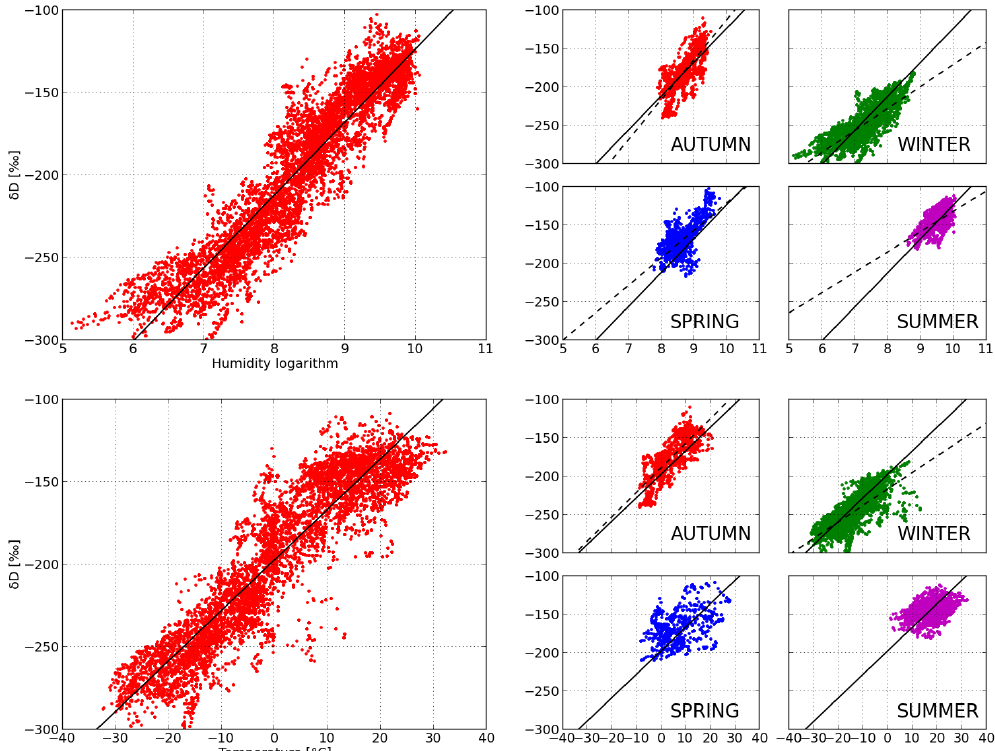
Figure 8. δ D vs. logarithm of humidity (top) and δ D vs. temperature (bottom). Left panels: all measurements, right panels: seasonal mea- Fig. 8. δ D vs. logarithm-of-humidity (top) and δ D vs. temperature (bottom). Left panels: all measure- surements, solid line: linear fit through all measurements, dashed line: linear fit through seasonal measurements. See Table 3 for calculations ments, right panels: seasonal measurements, solid line: linear fit through all measurements, dashed line: of determination coefficients and slopes. linear fit through seasonal measurements. See Table 3 for calculations of determination coefficients and slopes. Table 3. δ D vs. meteorological data (logarithm of humidity and temperature) (linear fit parameters for hourly averaged data). 35